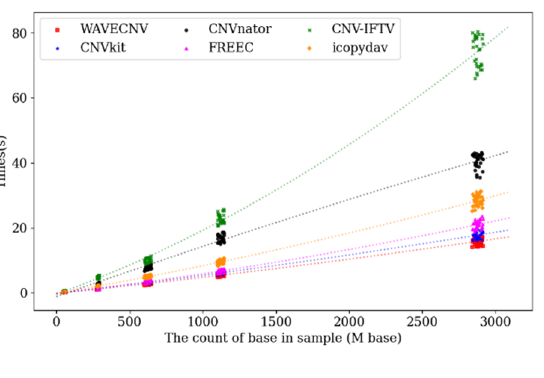
Figure 3. The precision, sensitivity, and F1 scores of the six methods are compared in the simulation data with different coverage and purity. The dotted line in the figure represents the contour line of the F1 score, the decimal of the title in the figure represents the tumor purity, and 4× and 6× represent 4 or 6 times the coverage. Among them, WAVECNV has the highest sensitivity and highest precision.